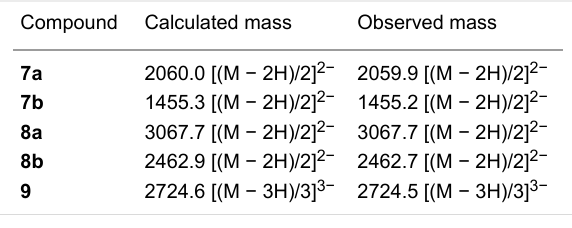
Table 1: ESIMS characterization of the support-bound nucleotides indicated in Scheme